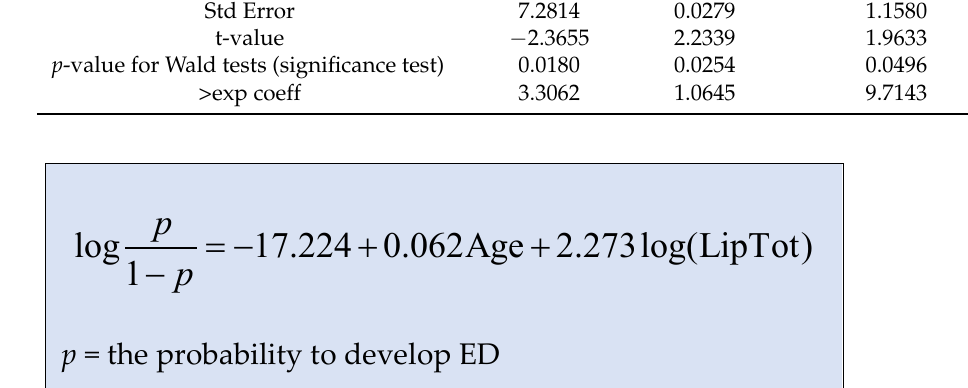
Figure 8. The probability model for assessing the ED.